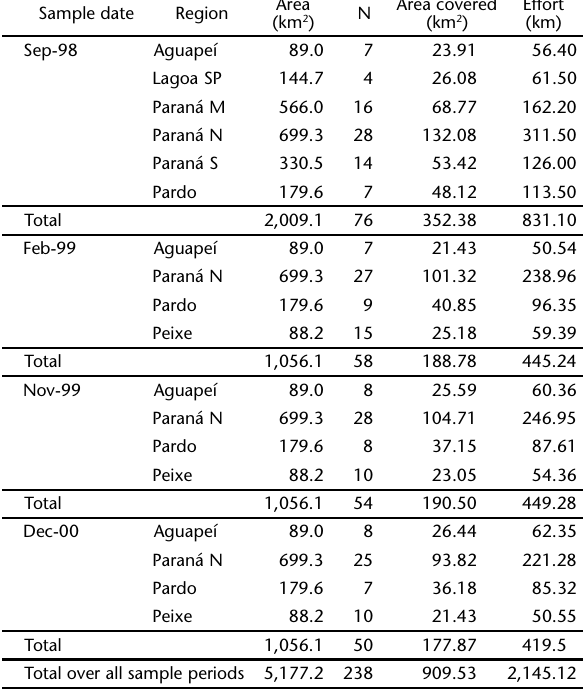
Table I. Summary of the sample regions surveyed in different years, including area, number of transects (N), area covered and